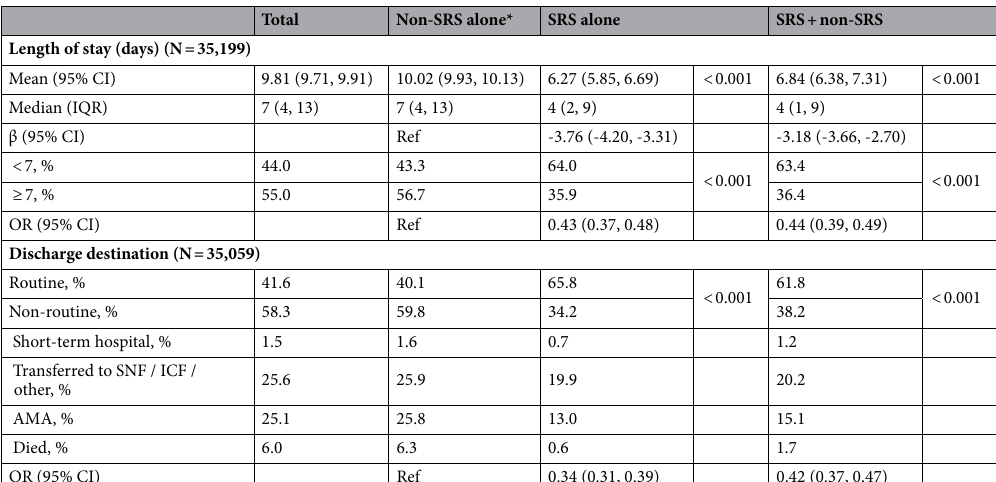
Table 2. Recipients of non-SRS alone, SRS alone and SRS + non-SRS for the treatment of brain metastases by hospitalization outcomes—2005–2014 Nationwide Inpatient Sample. AMA against medical advice, CI confidence intervals, IQR interquartile range, ICF intermediate care facility, OR odds ratio, SNF skilled nursing facility, SRS stereotactic radiosurgery. * Reference category.